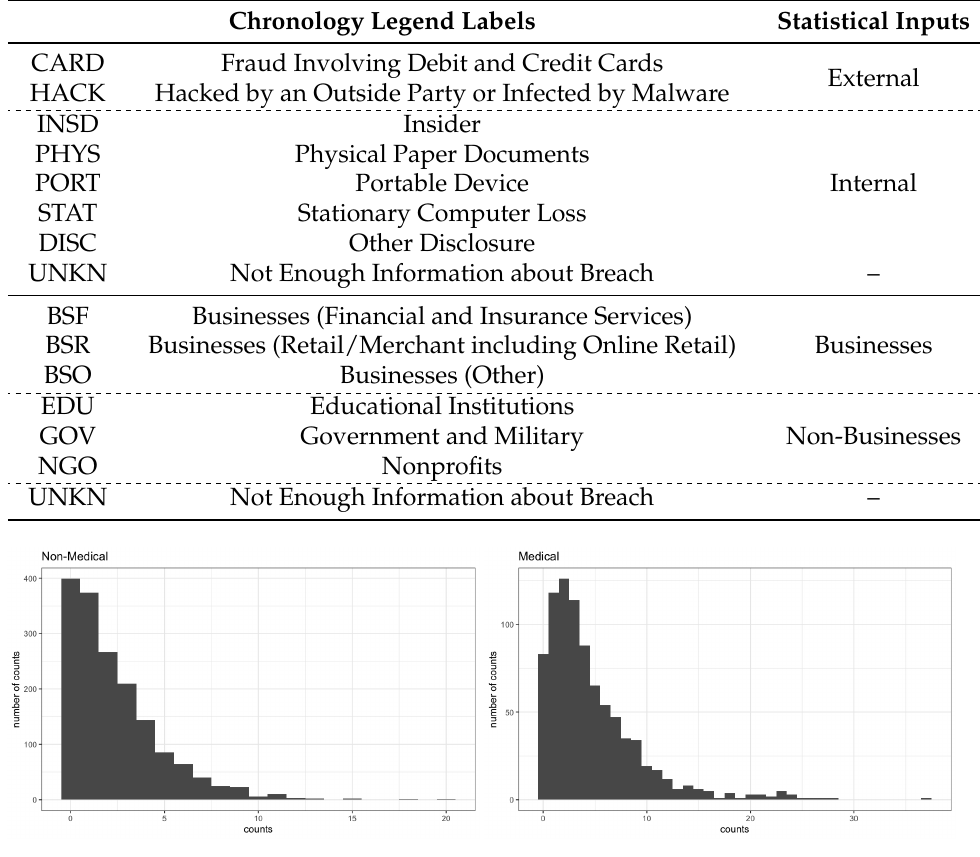
Figure 1. Histograms on different